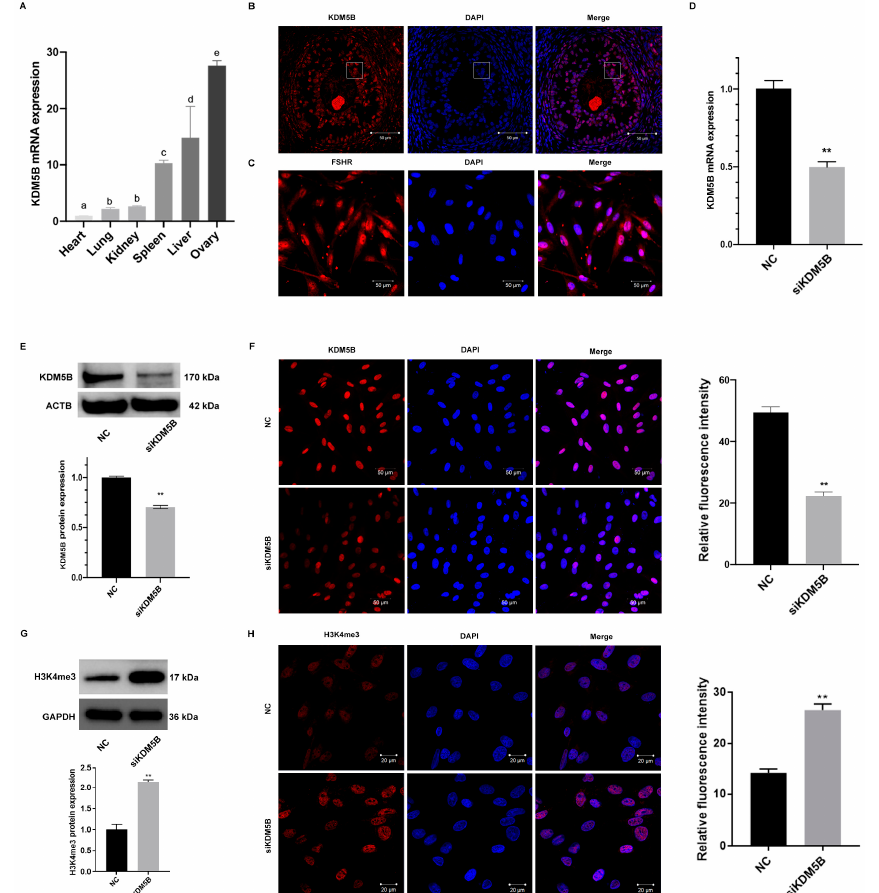
Figure 1. High expression and successful knockdown of KDM5B in goat GCs. ( A ) mRNA expression of KDM5B shows the highest level in goat ovary. Different letters (a–e) represent significant differences between groups, the same letter represents no significant differences between groups. ( B ) Immunofluorescence for KDM5B in goat ovary. KDM5B is located in goat GCs. The squares indicate granulosa cells. ( C ) FSHR is expressed in goat GCs specifically. ( D ) mRNA expression of KDM5B decreases signi fi cantly in KDM5B knockdown goat GCs relative to the NC group. ( E ) KDM5B protein level decreases signi fi cantly in goat GCs treated with siKDM5B compared to the NC group, as determined by Western blot. ( F ) Immuno fl uorescence with KDM5B antibody proves that the protein level of KDM5B decreases signi fi cantly. ( G ) H3K4me3 level increases signi fi cantly in goat GCs treated with siKDM5B compared to the NC group, as determined by Western blot. ( H ) Immuno fl u- orescence with H3K4me3 antibody proves that the H3K4me3 level increases signi fi cantly. ** means p < 0.01. 3.2. Knockdown of KDM5B in Goat GCs We next transfected siRNAs against KDM5B into the goat GCs to knockdown the expression of KDM5B. As expected, the mRNA expression of KDM5B decreases signi fi - cantly in the KDM5B knockdown GCs compared to the controls ( p < 0.01; Figure 1D). Fur- thermore, the protein level of KDM5B also signi fi cantly decreases as revealed by Western blot and immuno fl uorescence staining ( p < 0.01; Figure 1E,F). As KDM5B demethylates H3K4me2/3, we explored changes in the H3K4me3 methylation levels. As shown in Figure 1G,H, H3K4me3 methylation levels increase signi fi cantly in the KDM5B knockdown GCs compared to the NC group, as revealed by Western blot and immuno fl uorescence stain- ing. These data suggest that the expression of KDM5B has been successfully knocked down.